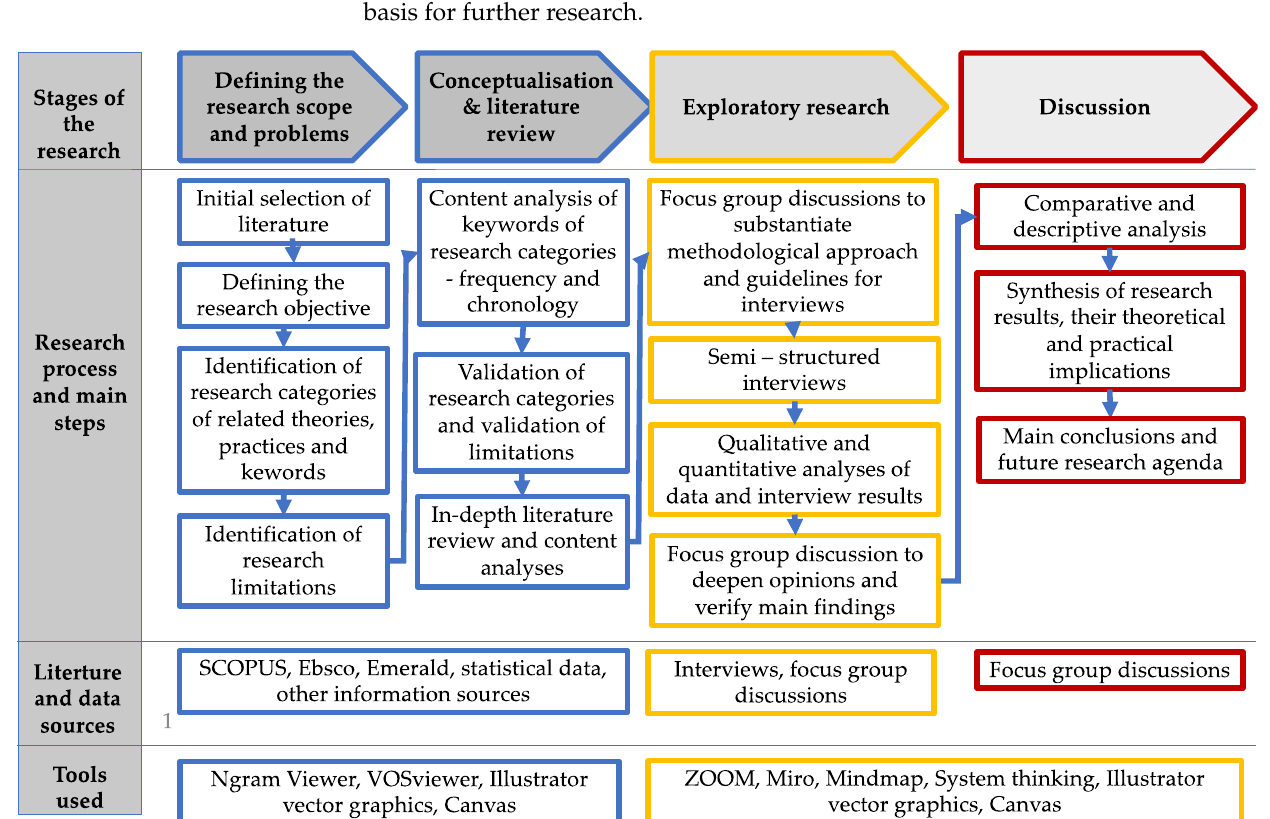
Figure 6. The methodological framework of this research (source: the authors).